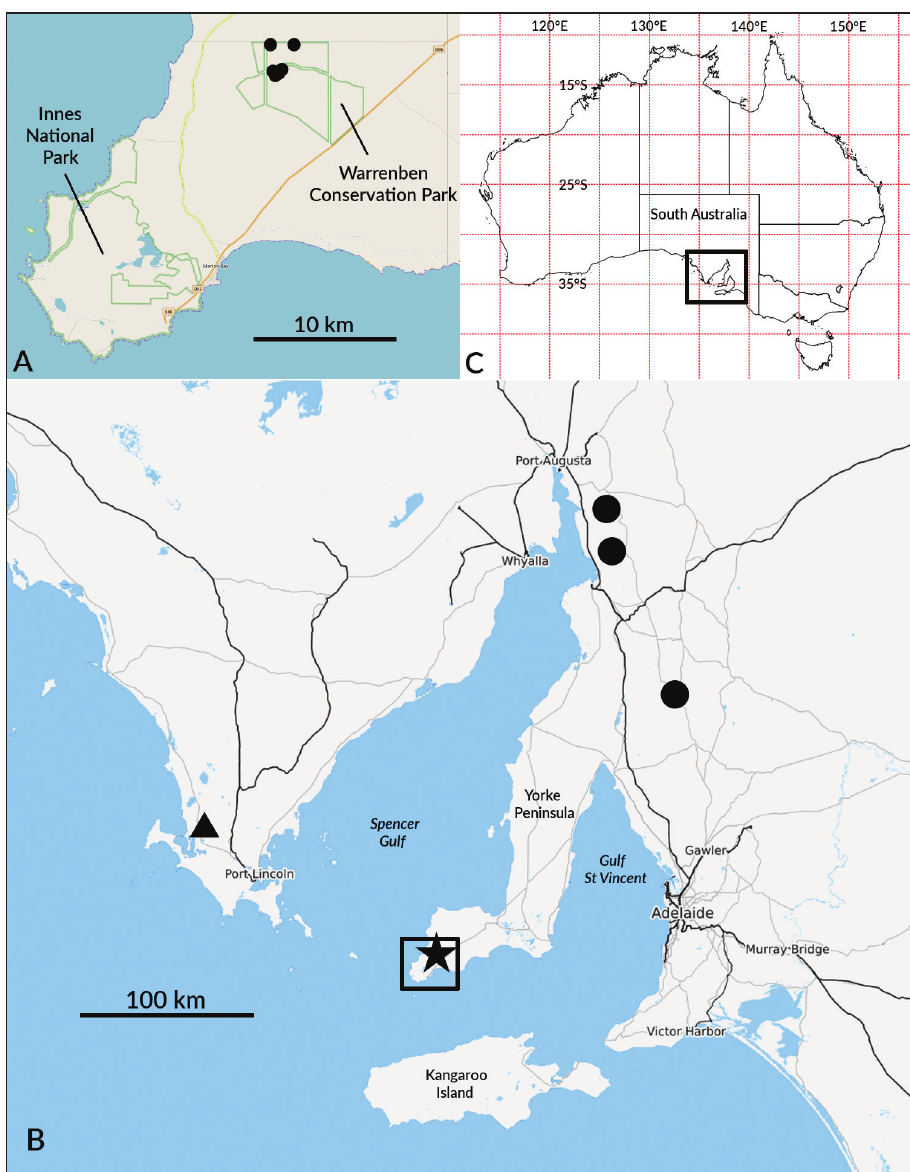
Figure 1. Known distribution of Tridactylogonus species as of 1 September 2017. A Localities for T. warrenbenensis sp. n. (filled circles) in Warrenben Conservation Park B Localities for T. obscurus Jeekel, 1982 (filled circles), T. rugosissimus Jeekel, 2002 (triangle) and T. warrenbenensis sp. n. (star); rectangle on Yorke Peninsula shows extent of map A . C Map of Australia; rectangle in South Australia shows extent of map B . Locality data for T. obscurus and T. rugosissimus from Mesibov (2006–2017); base maps for maps A and B from Open Street Map project